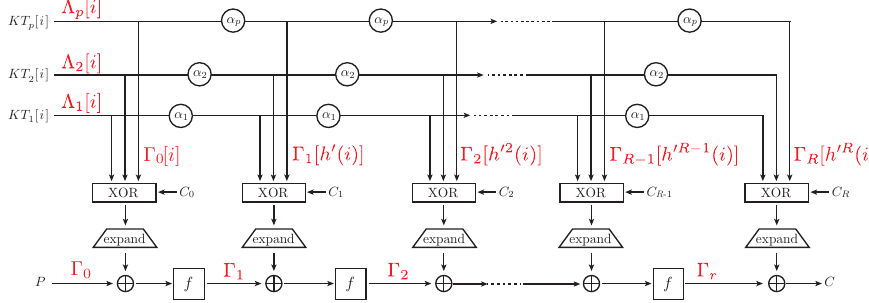
Figure 12: Zero-correlation linear hull on the STK with TK - p